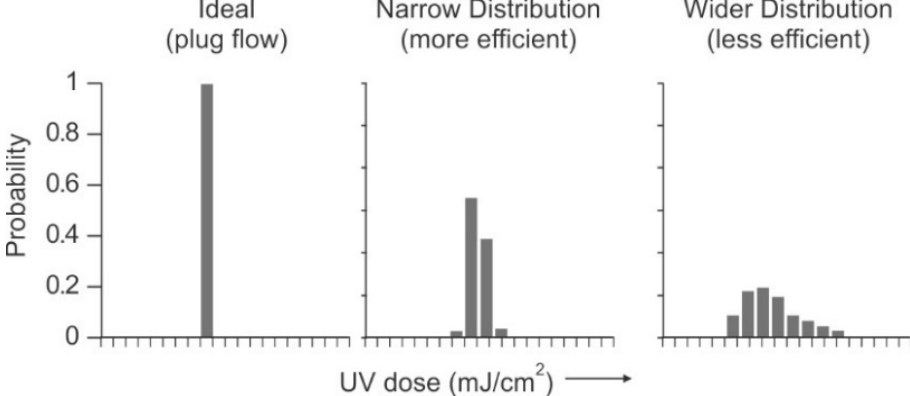
Figure 14. Examples of possible dosage distributions for ideal and continuous-flow UV reactors.